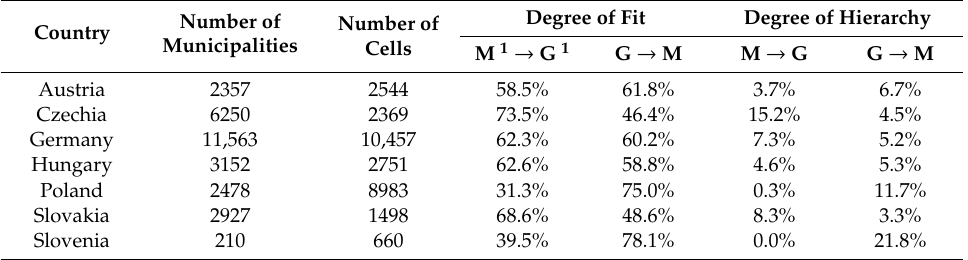
Table 3. Goodness of fit statistics for municipal structure and 6 km regular grid in respective countries.